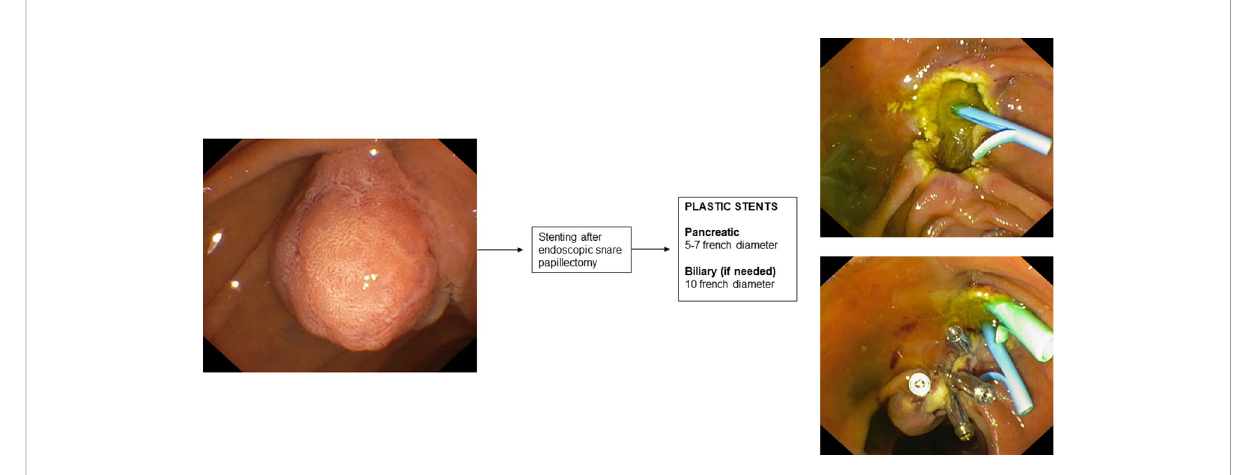
FIGURE 7 Stenting after endoscopic snare